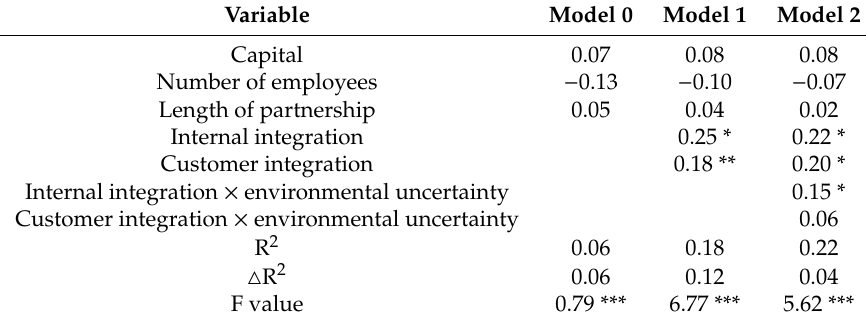
Table 5. Supply chain integration and relationship stability with